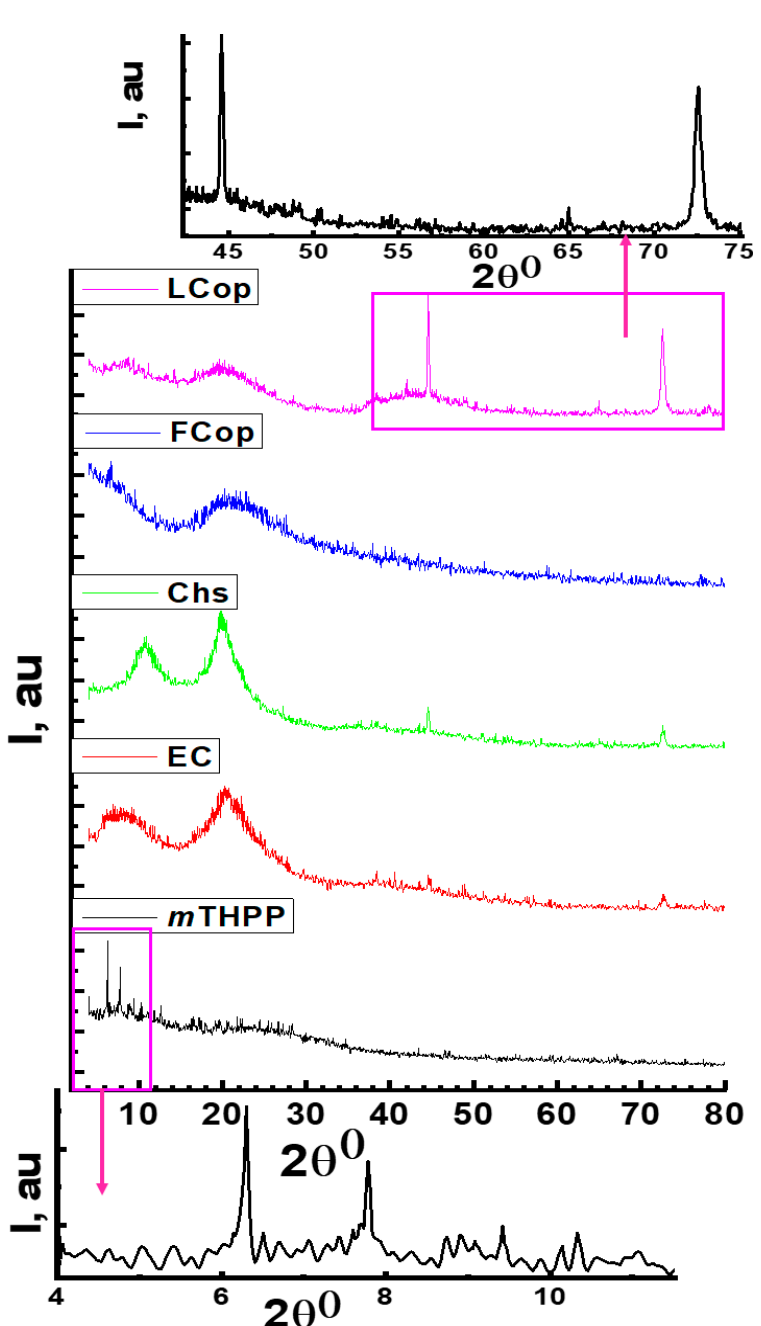
Figure 4. XRD pattern of m THPP, EC, Chs, free composite, and m THPP-loaded nanocomposite.